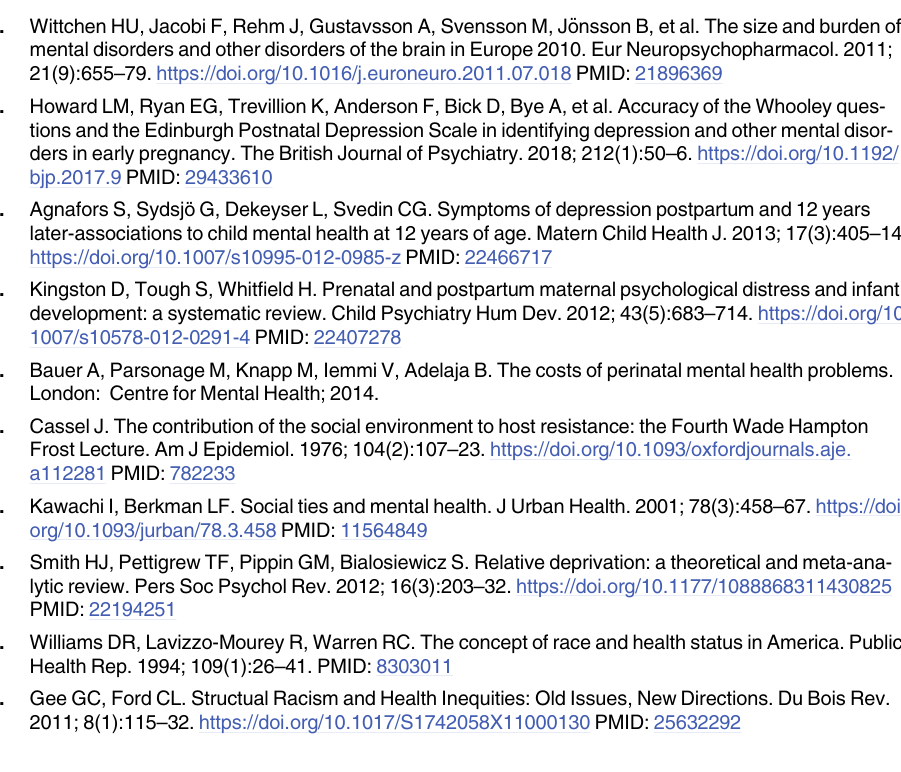
S1 Table. Absolute and relative differences in case-finding equity. S2 Table. Absolute and relative differences in management equity (Redshaw and Hender- son, 2016)